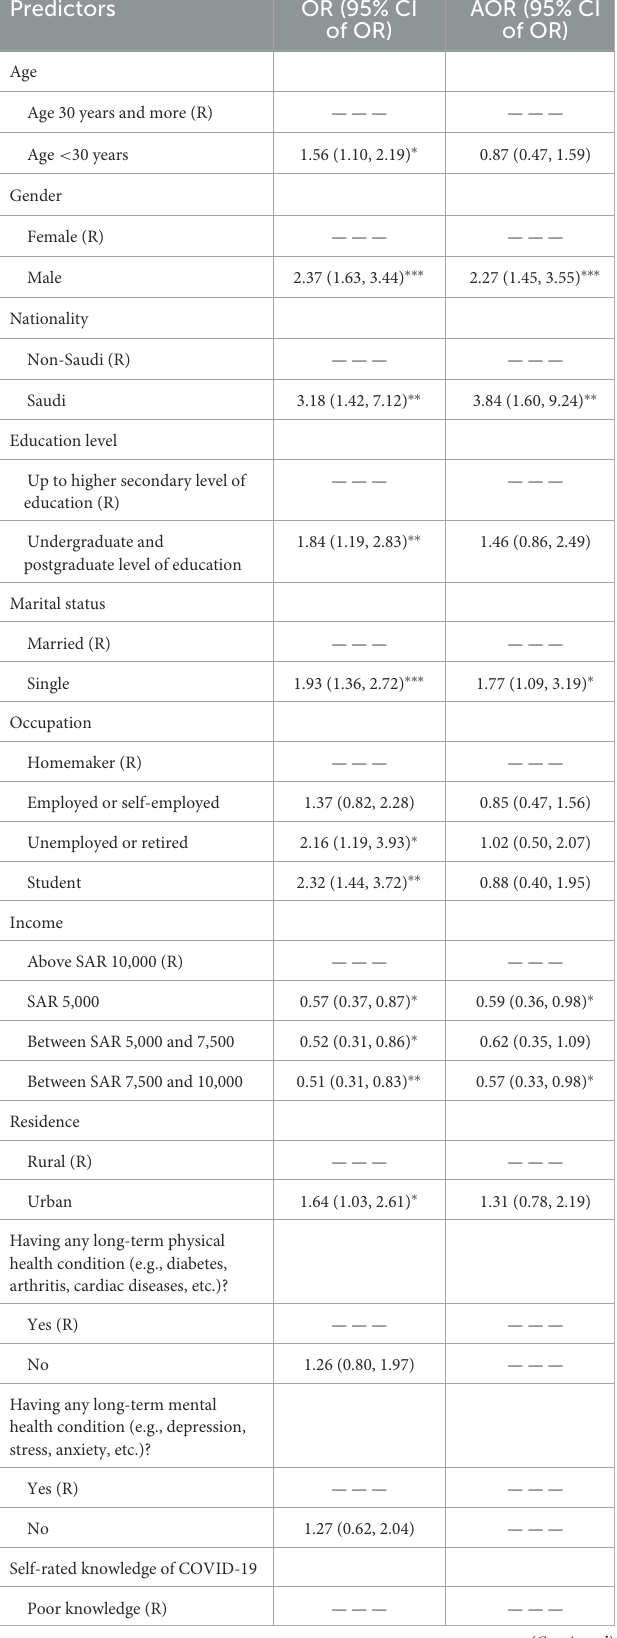
TABLE 5 Determinants of positive intention toward COVID-19 vaccination.